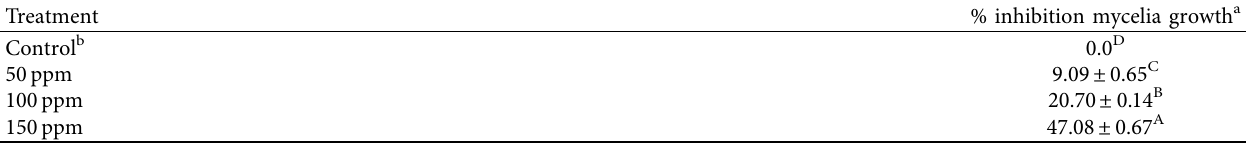
Table 2: Antifungal activity of AgNPs on in vitro mycelial growth of Fusarium oxysporum f. sp. lycopersici . Treatment